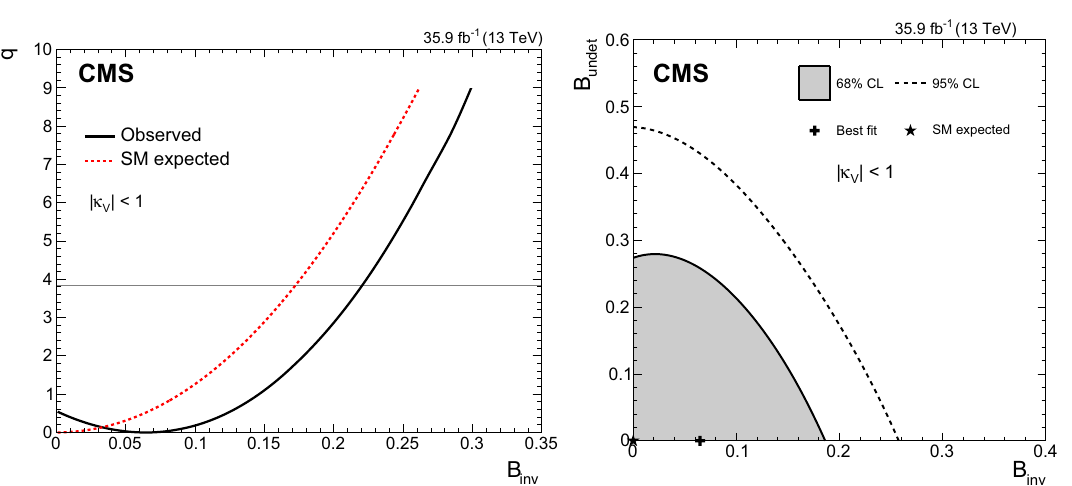
Fig. 12 Results within the generic κ -framework model with effective loops and with the constraint | κ W | , | κ Z | ≤ 1 (same sign of κ W and κ Z ), and with B inv > 0 and B undet > 0 as free parameters. Scan of the test